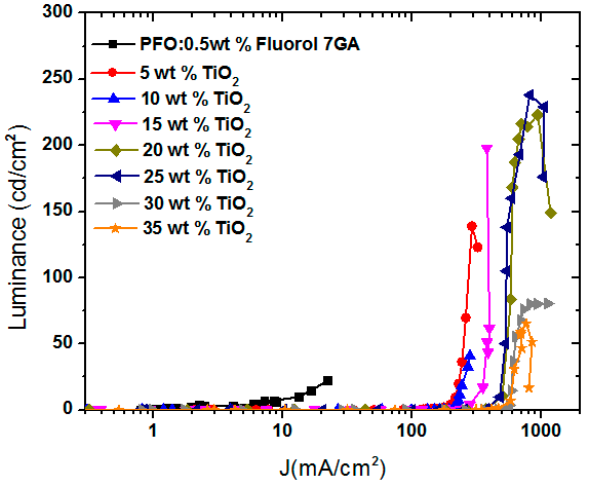
Figure 5. Luminance—current density characteristics for PFO/Fluorol 7GA with various weight ratios of TiO 2 NPs.